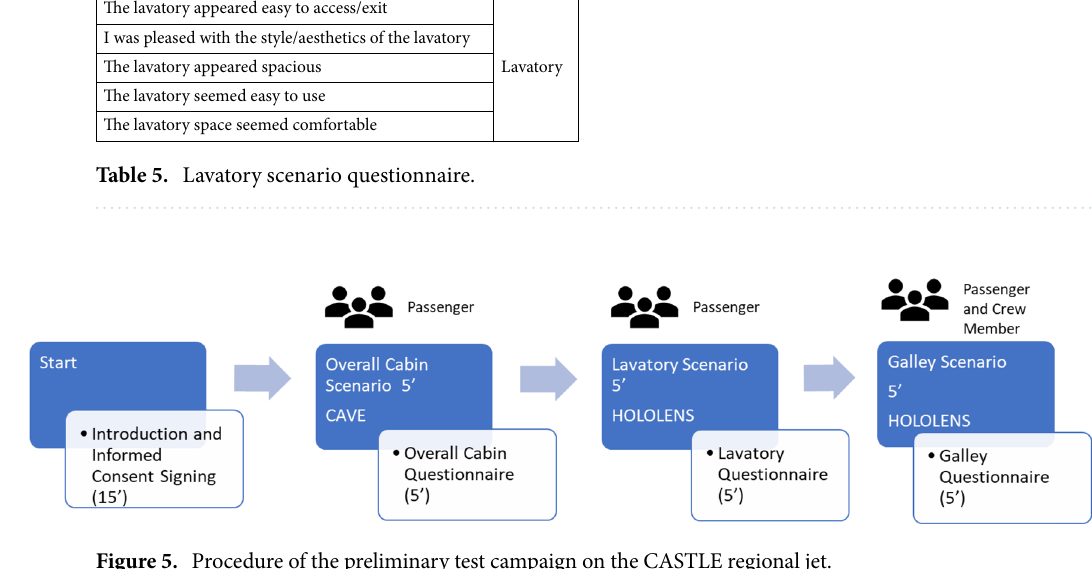
Figure 5. Procedure of the preliminary test campaign on the CASTLE regional